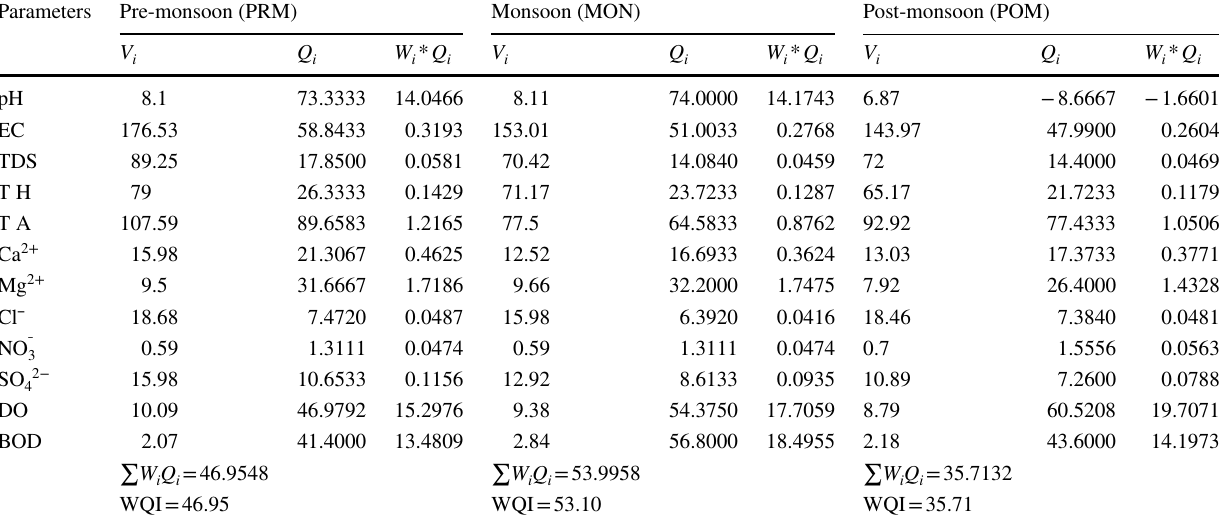
Table 7 Calculation of WQI at station 3 (S 3)